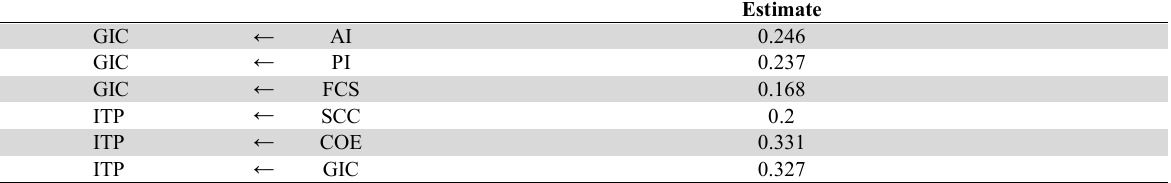
Standardized Regression Weights: (Group number 1 - Default model)